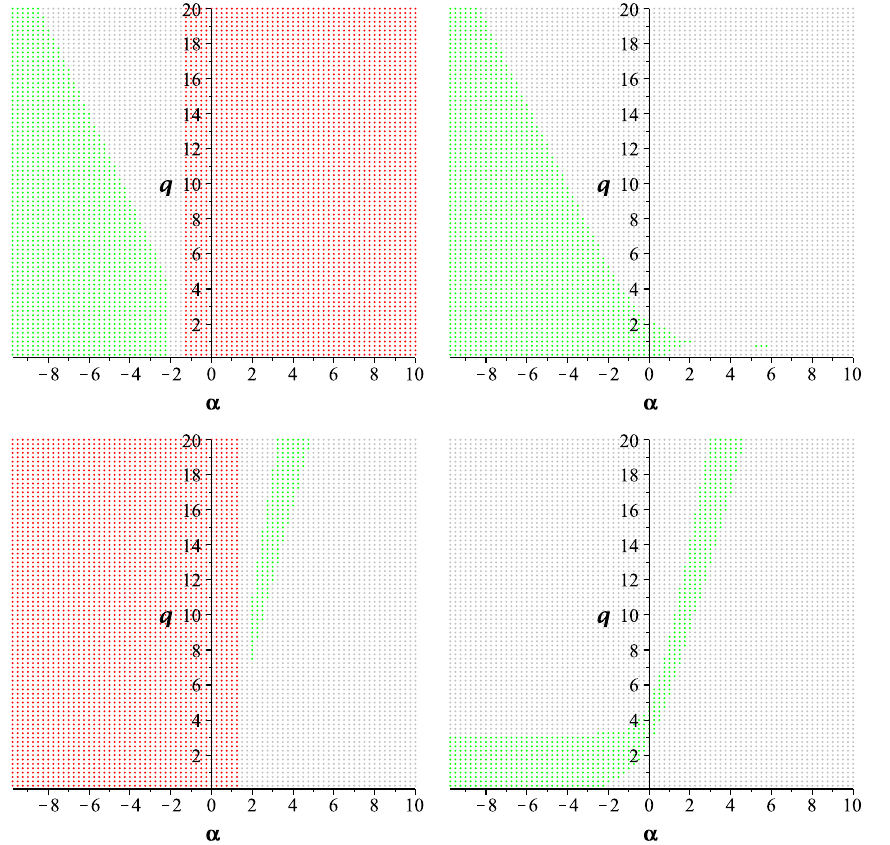
Figure 9 . Parameter space for isolated critical points: Top left : plot for (cid:14) = +1, k = +1 and (cid:15) = +1. Top right : plot for (cid:14) = +1, k = +1 and (cid:15) = (cid:0) 1. Bottom left : plot for (cid:14) = (cid:0) 1, k = (cid:0) 1 and (cid:15) = +1. Bottom right : plot for (cid:14) = (cid:0) 1, k = (cid:0) 1 and (cid:15) = (cid:0) 1. In each plot, green dots indicate that for the selected parameters all thermodynamic parameters are positive and the (pressure and entropy) constraints are satis(cid:12)ed, grey dots indicate that for the chosen parameters at least one of the constraints is violated, red dots indicate that at least one of the thermodynamic parameters is imaginary. All other combinations of (cid:14); k and (cid:15) lead to situations where the physicality conditions cannot be